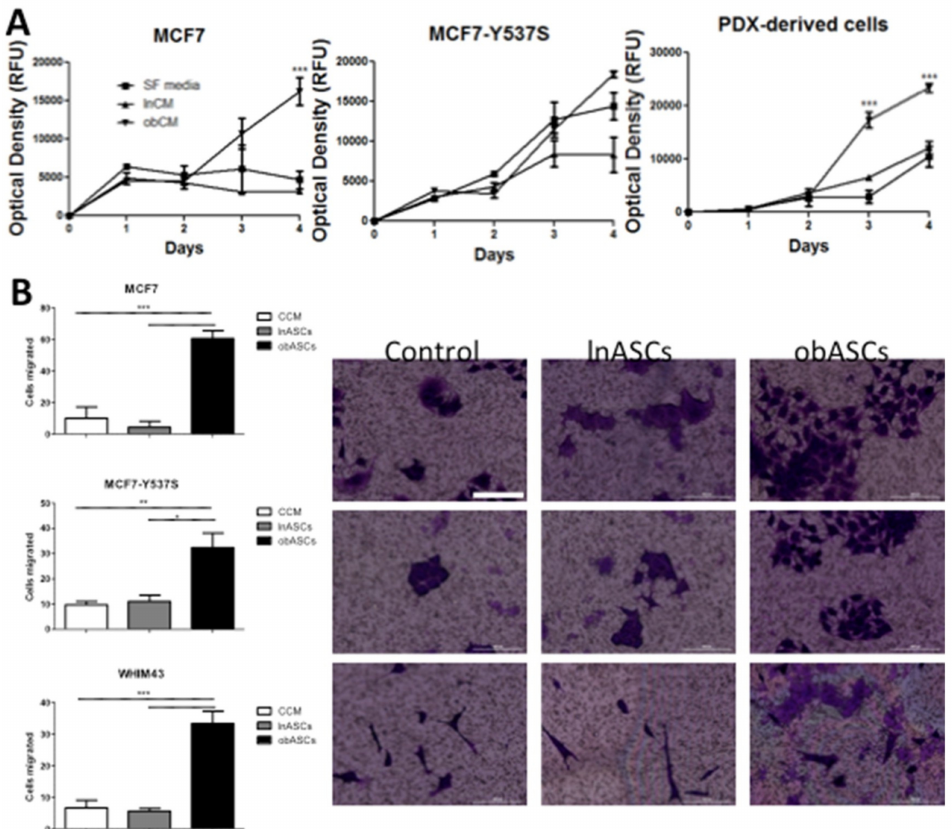
Figure 2. In an estrogen-depleted environment, obASCs promote proliferation and migration of